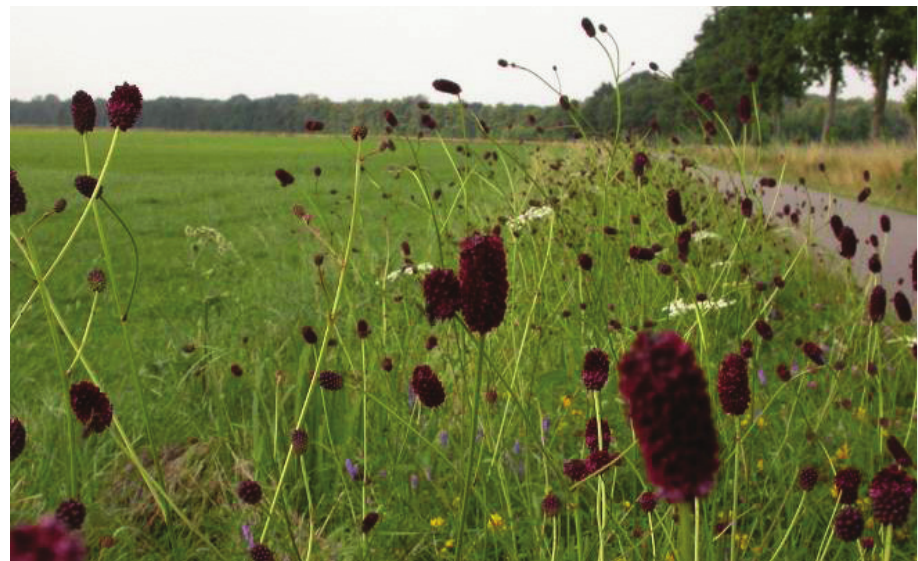
Habitat Phengaris nausithous , Netherlands. Photo: Chris van Habitat and ecology The Dusky Large Blue occurs on damp, moderately nutrient-rich grassland and rough vegetation. The butterflies are usually found on or near the foodplant Great Burnet ( Sanguisorba officinalis ). Having lived on the flowerheads of this plant for a few weeks, the small caterpillars go down to the ground, in order to be carried away usually by workers of the ant Myrmica rubra to an ant nest. There, they remain feeding on ant grubs, hibernating and pupating in the early summer. The newly-emerged butterflies leave the nest. The Dusky Large Blue is one of the most specialized of the “ant blues” being most adapted to one species of host ant. Populations using Myrmica scabrinodis as the main host ant are extremely rare and probably confined to the edge of the range or to east Europe. The Romanian populations belong to the subspecies kijevensis and prefer Myrmica scabrinodis as host ant. The Dusky Large Blue has one generation a year. Habitats: humid grasslands and tall herb communities (36%), water-fringe veg- etation (15%), blanket bogs (12%), fens, transition mires and springs (9%), dry sili- ceous grasslands (6%), mesophile grasslands (6%). In Germany, the Rhone valley and parts of Poland, it supports a beautiful, highly specialized ichneumonid parasitoid Neotypus ‘pusillus’ , which possibly consists of two cryptic species centred on Germany- Poland and the Rhone valley, each host-specific to P. nausithous. Red List link : http://www.iucnredlist.org/apps/redlist/details/12662/1 Red List Status Europe: Near threatened EU: Near threatened